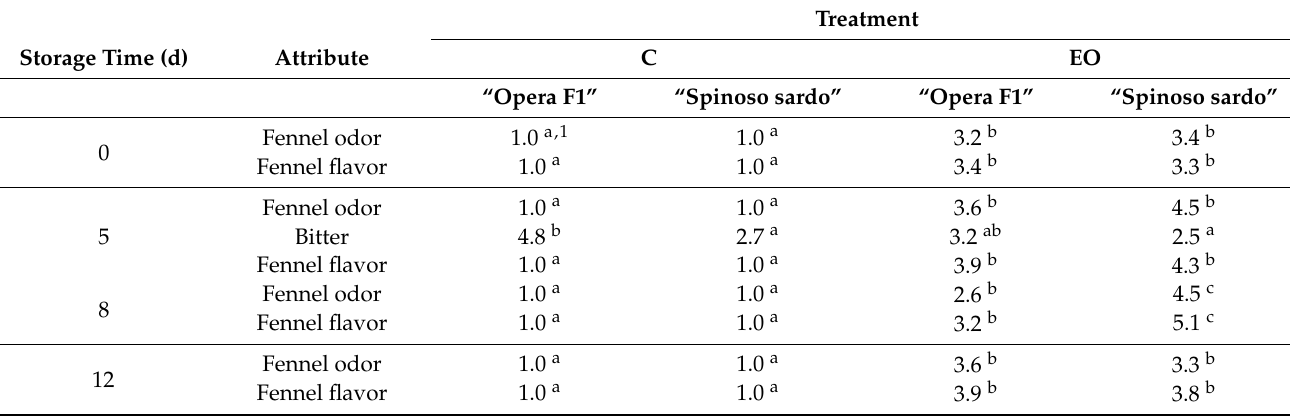
1 Values marked with different letters in the same row are significantly different ( p ≤ 0.05) according to the LSD test. C: Control; EO: Samples packed with essential oil of F. vulgare